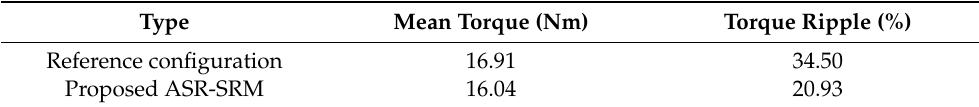
Table 8. Optimization variables for the chosen